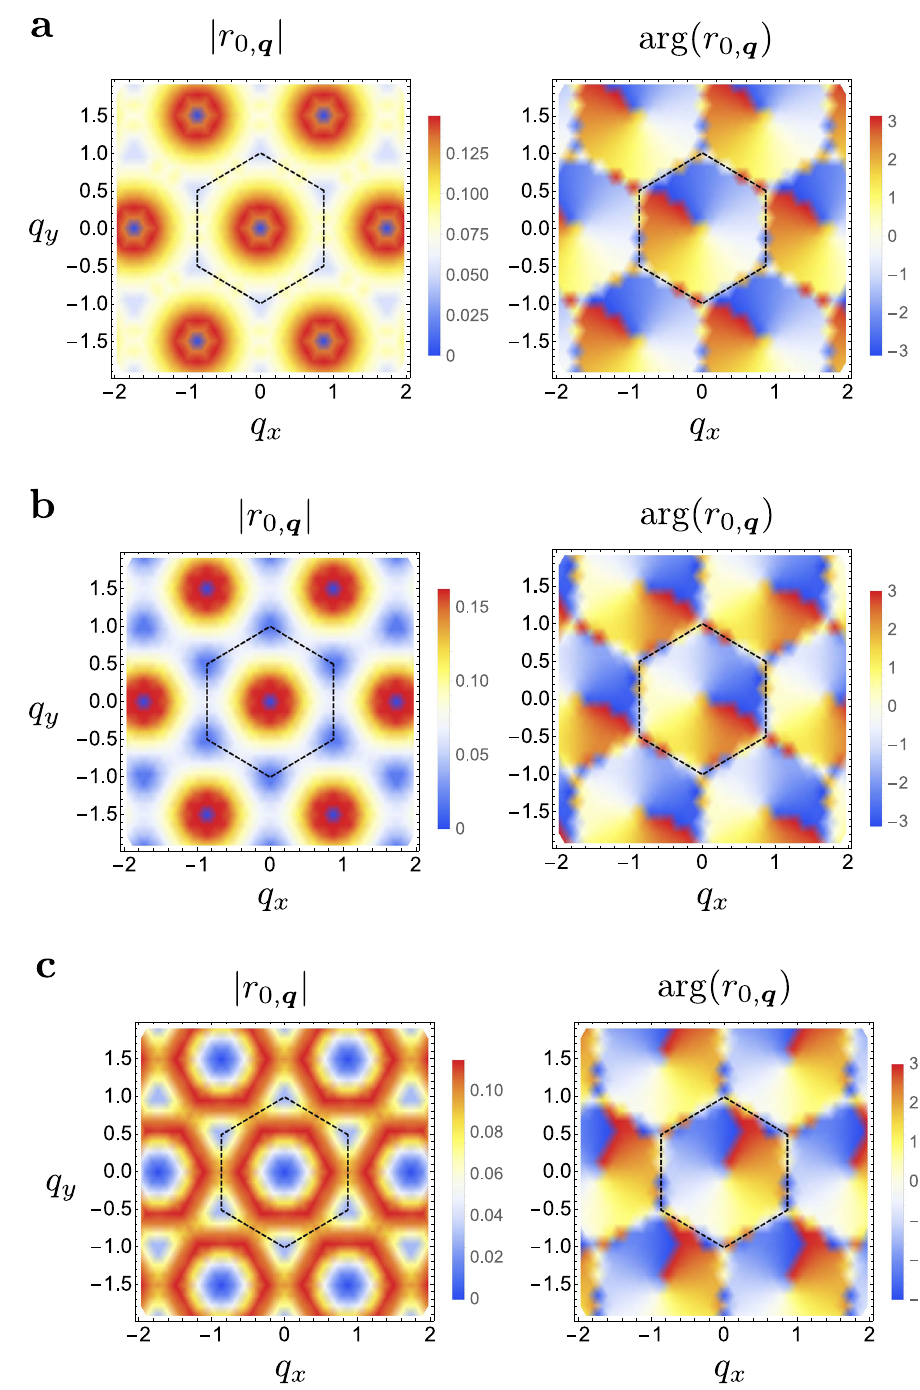
Fig. 2 | Polaron wavefunctions. Color plot of the polaron wavefunction as a function of the magnon momentum q (cf. Eq. (8)) for a the LLL, TBG bands ( b ) with fl at quasiparticle dispersion, and c for the electron (hole) doping the ν = − 3 ( ν =+3) insulator.